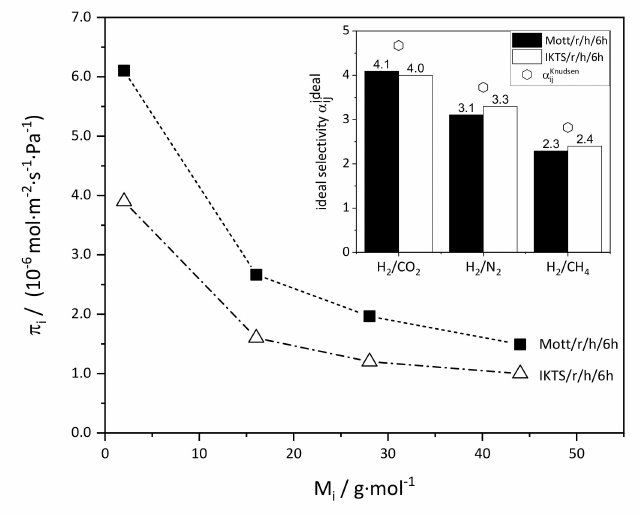
Figure 16. Single gas permeance (T = 25 ◦ C, ∆ p = 1 bar) and ideal selectivity through ZIF-11 mem- branes as a function of the molecular mass of the measured gas M i . The membranes were prepared on symmetric stainless-steel (Mott/r/h/6h) and asymmetric α -Al 2 O 3 supports (IKTS/r/h/6h) by rub seeding and 6 h of secondary growth in DEF at 60 ◦